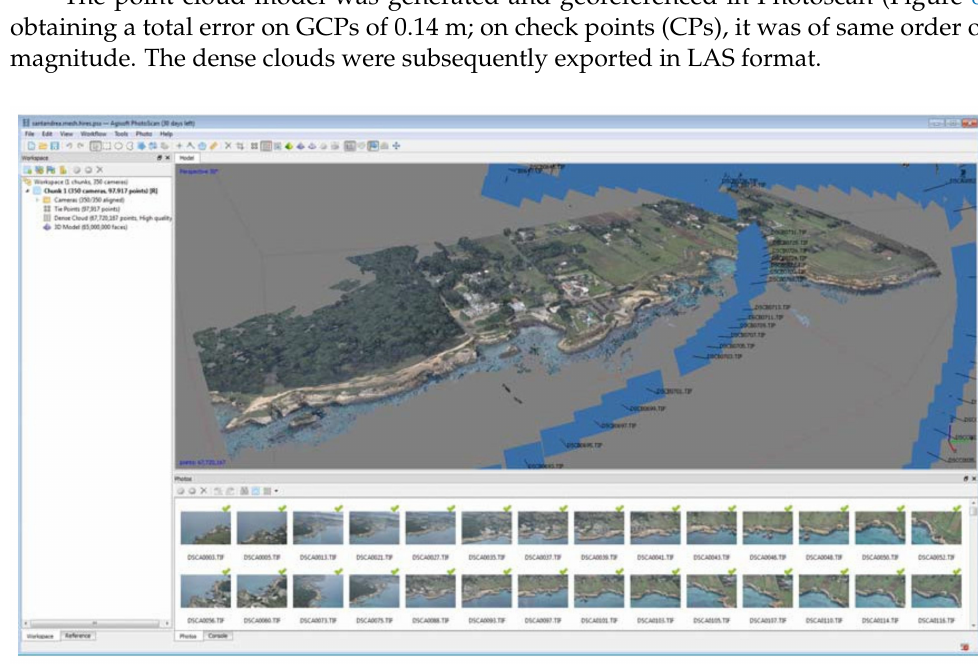
Figure 8. Print screen of the processes performed in Photoscan